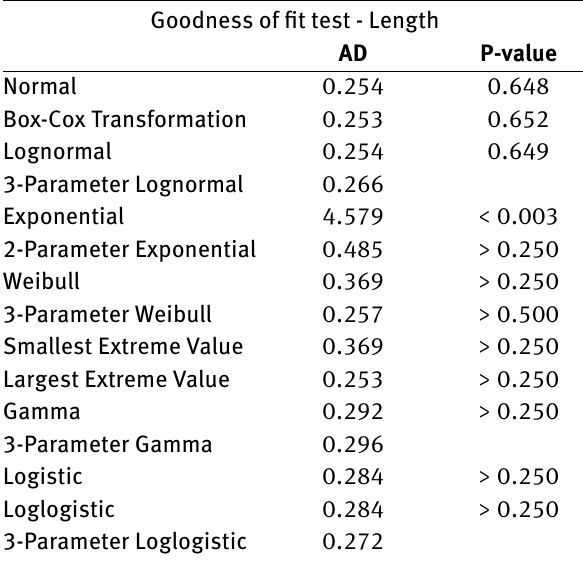
Table 4: Individual distribution identification for the length of speci- mens.